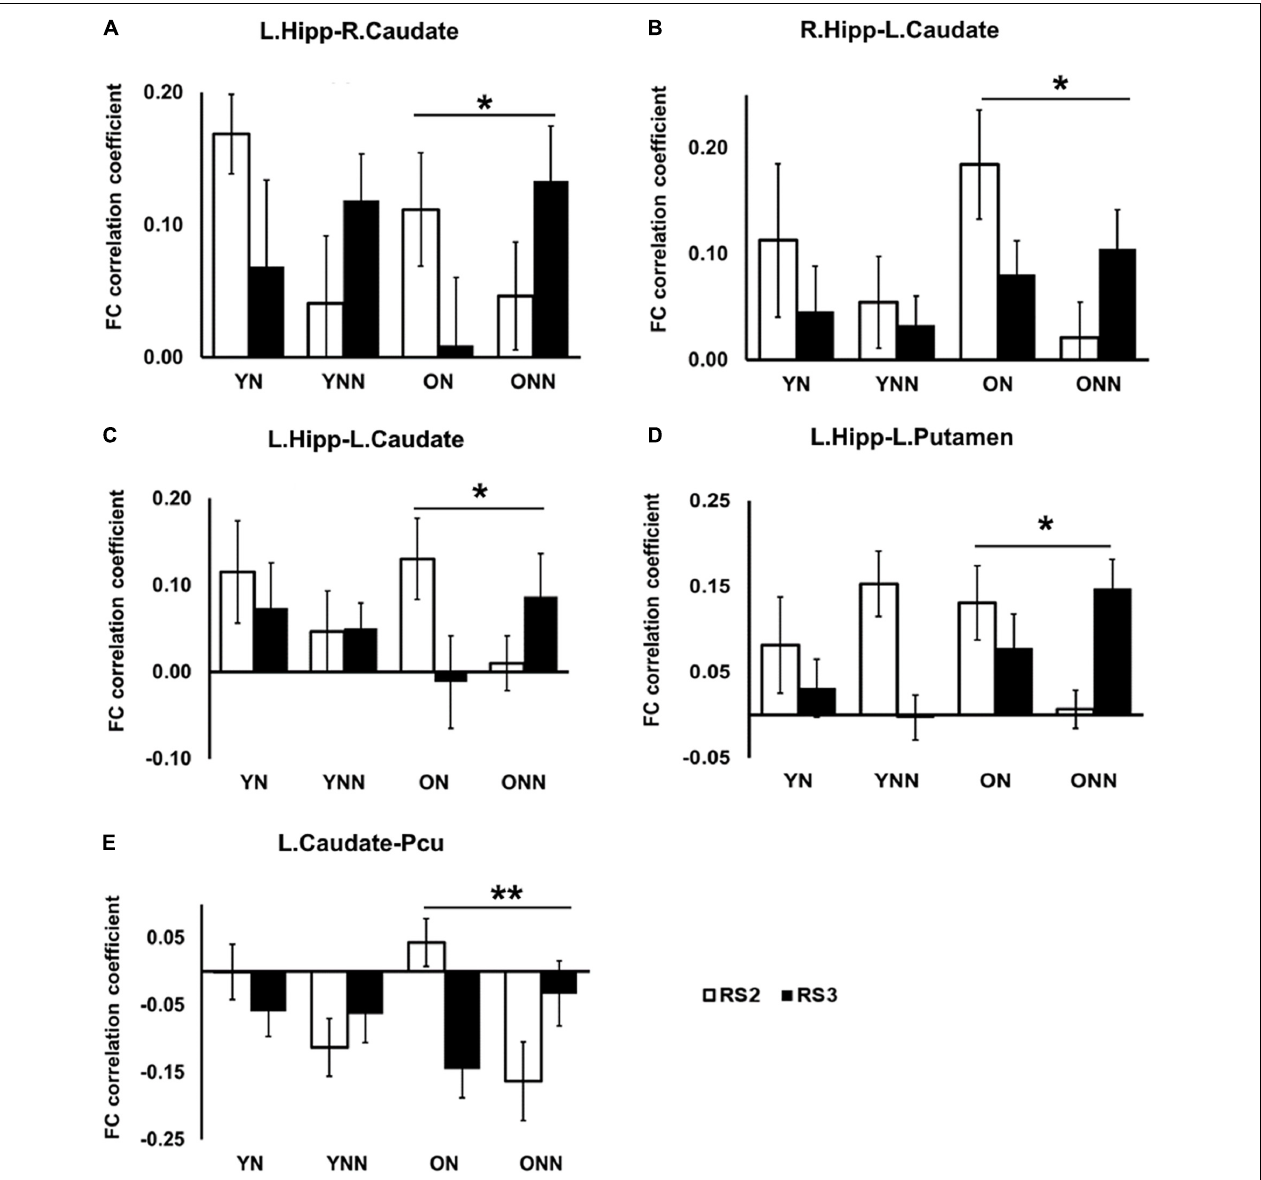
FIGURE 7 | Post hoc analysis of the decreased FC between hippocampus and striatal area, and decreased FC between caudate and precuneus in the ON group following nap. Significant sleep × scan interaction effects on FC were observed in the older group between (A) left hippocampus and right caudate; (B) right hippocampus and left caudate; (C) left hippocampus and left caudate; (D) left hippocampus and left putamen; (E) left caudate and precuneus, while no such effect was found in the young group. *Indicates significant nap × session interaction effects in the older group (*pFDR < 0.05; **pFDR < 0.01). L., left; R., right; Hipp., hippocampus; Pcu, Precuneus. YN, Young Nap; YNN, Young No Nap; ON, Older Nap; ONN, Older No